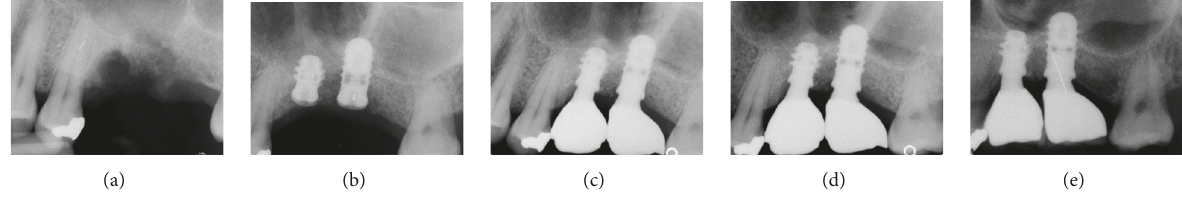
Figure 4: Two implants (#25 and #26) inserted with the transalveolar osteotomy technique: (a) preoperative rx; (b) the implants placed after the sinus elevation with the Summers technique; (c) radiographic control 1 year after implant placement; (d) radiographic control 5 years after implant placement; (e) radiographic control 10 years after implant placement.